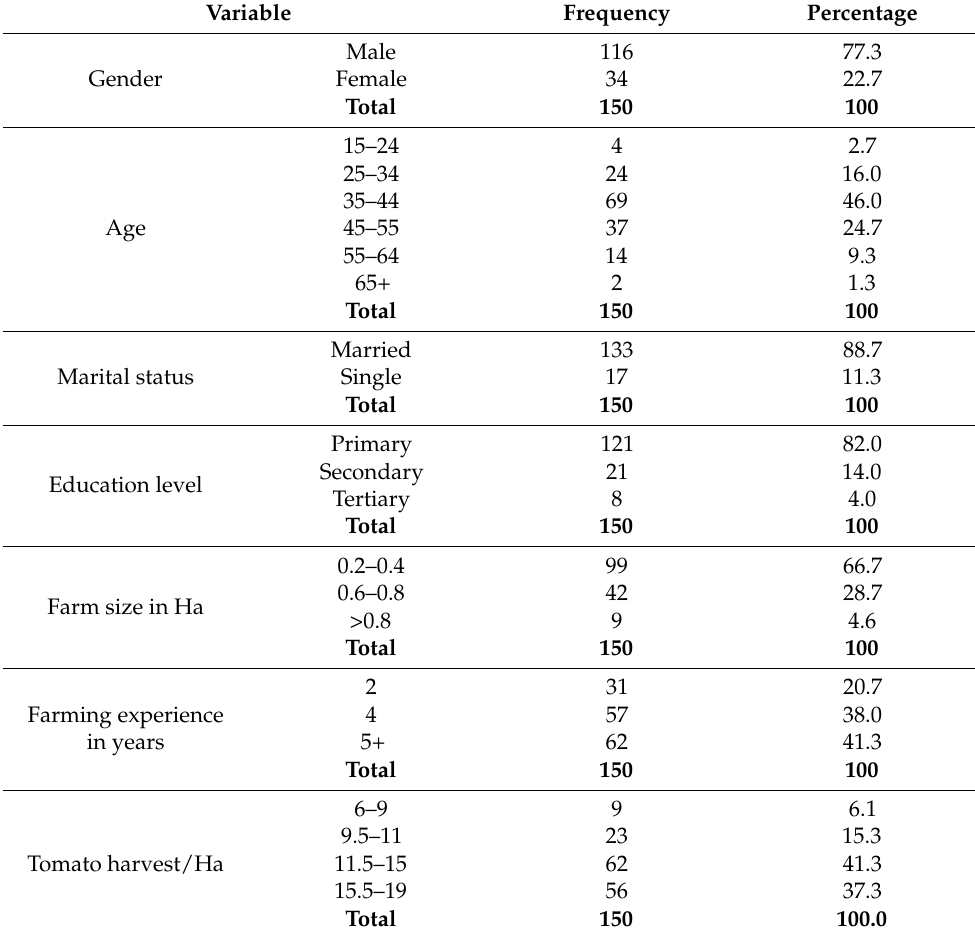
Table 2. Socio-economic characteristics of the study respondents and their tomato